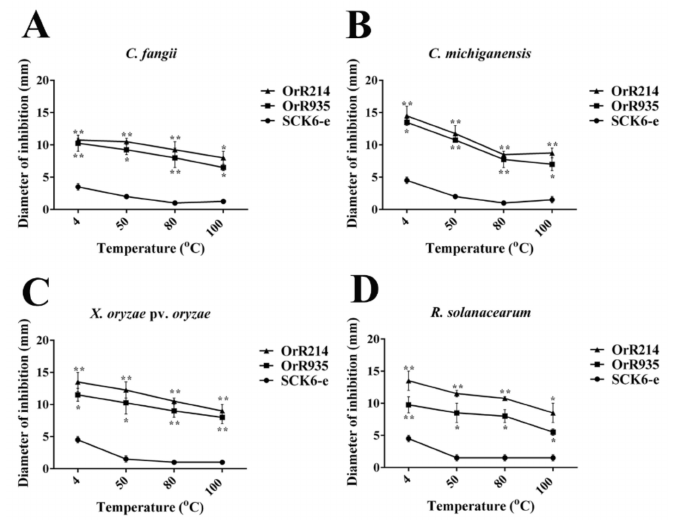
Figure 3. Stabilities of the antimicrobial peptides. Bacteriostatic maps of four indicator bacteria ( C. fangii , X. oryzae pv. oryzae, C. michiganensis , and R. solanacearum ) on the plate at di ff erent temperatures. ( A ) ( C. fangii ), ( B ) ( C. michiganensis ), ( C ) ( X. oryzae pv. oryzae), and ( D ) ( R. solanacearum ) are graphs of the bacteriostatic diameters of two peptides at various temperatures (4 ◦ C, 50 ◦ C, 80 ◦ C, and 100 ◦ C). Three individual experimental data points were collected for the mean values. SD is represented by vertical bars. T-tests were conducted for significance analysis at * p ≤ 0.05 and ** p ≤ 0.01.